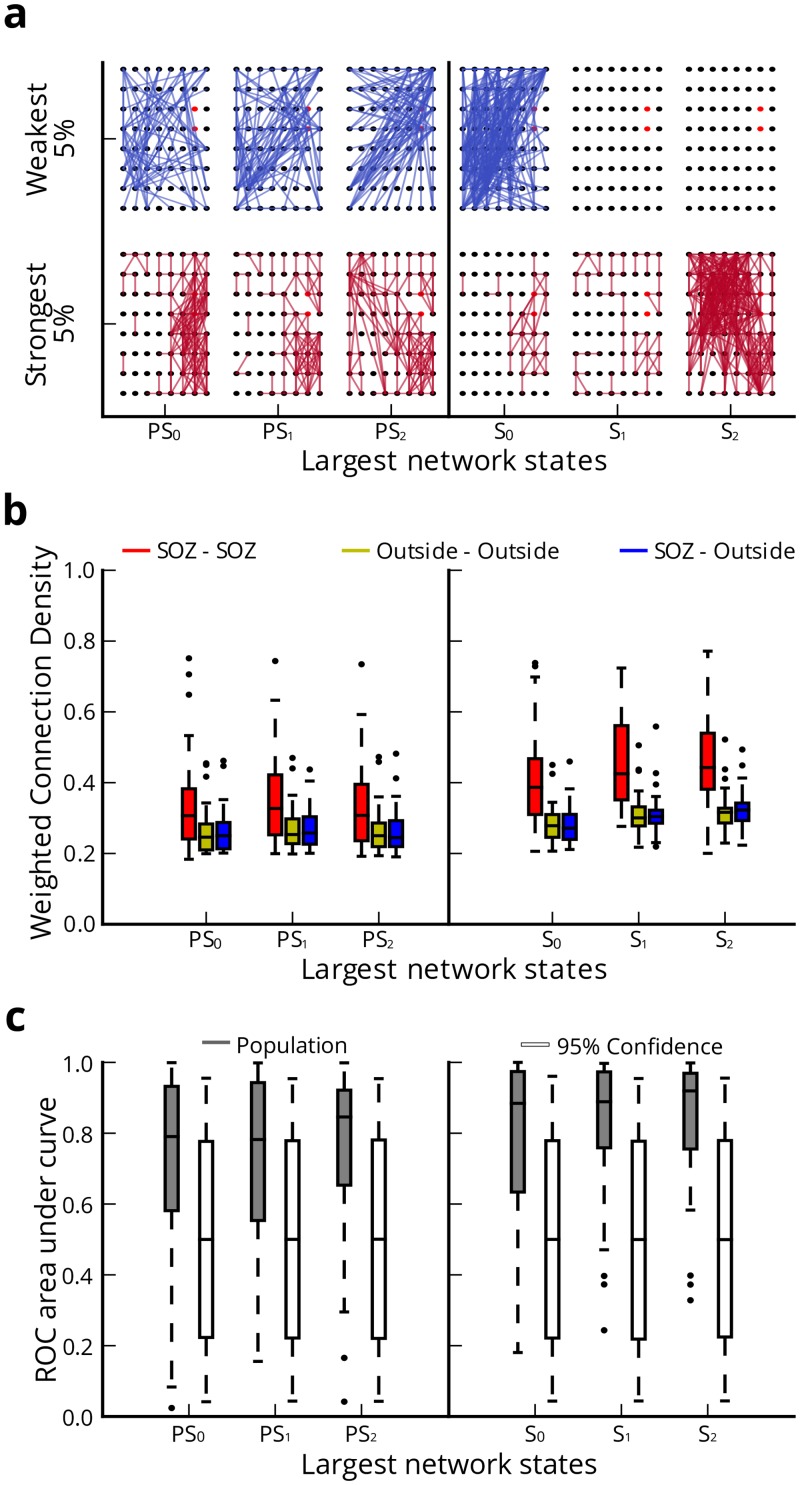
Regional characteristics of network geography.(a) Example of network geography with preserved 2-D spatial relationships between nodes for categories of strongest and weakest connections in upper and lower 5% of connection strength distribution; Connection colors indicate weak (blue) and strong (red); the clinically-determined seizure onset sensors are shown in red. (b) Connection strength within 3 geographic connection types during PS and S network states (N = 50). During PS and S, we observed significantly stronger connections amongst SOZ-SOZ regions than OUT-OUT and SOZ-OUT regions. During S, we observed significant increase in SOZ-SOZ connections as seizures initiate and progress. (c) ROC AUC compared to 95% bootstrapped confidence intervals using connection strength to predict SOZ-SOZ connections during PS and S network states (N = 50). The synchronized S
2 state yielded the best performance, while the desynchronized PS
0 state yielded the worst performance.